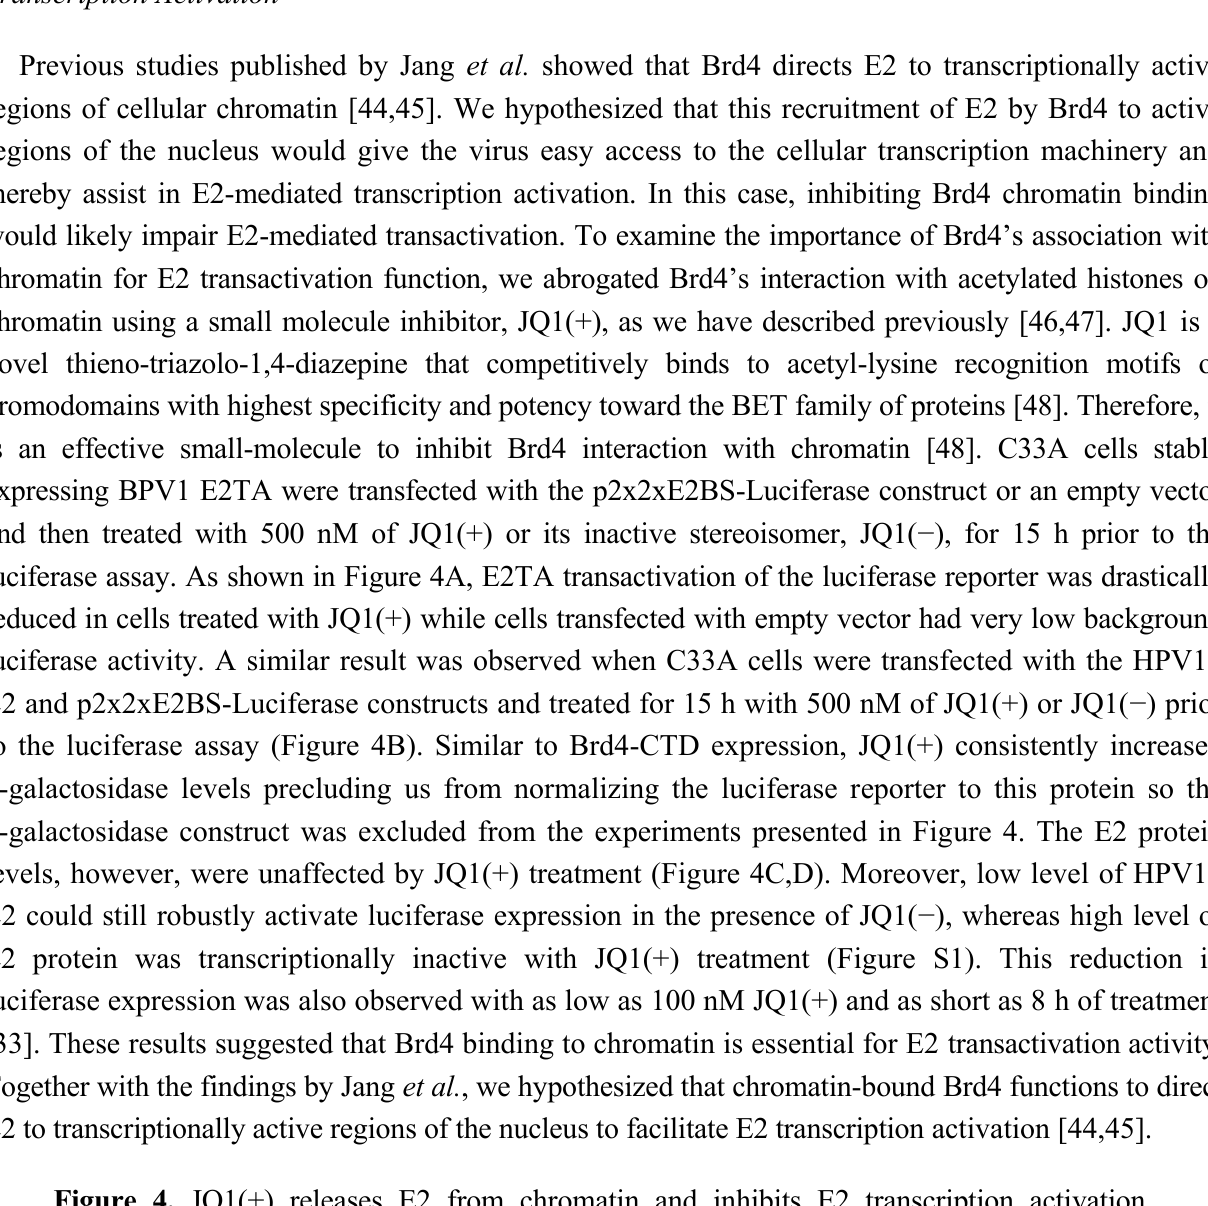
Figure 4. JQ1(+) releases E2 from chromatin and inhibits E2 transcription